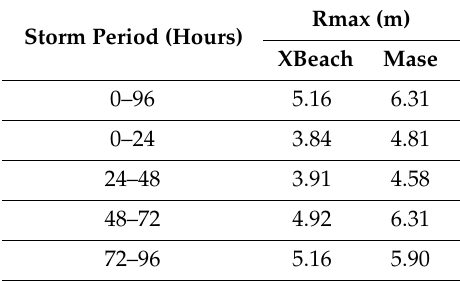
Figure 12. Maximum run-up time series predicted using XBeach and the Mase formulas for field storm conditions and seawall freeboard level, considering a varying beach sandy bottom profile in case II.VP. Table 6. Maximum wave run-up predicted using XBeach and Mase formulas for field storm conditions considering a varying beach sandy bottom profile in case